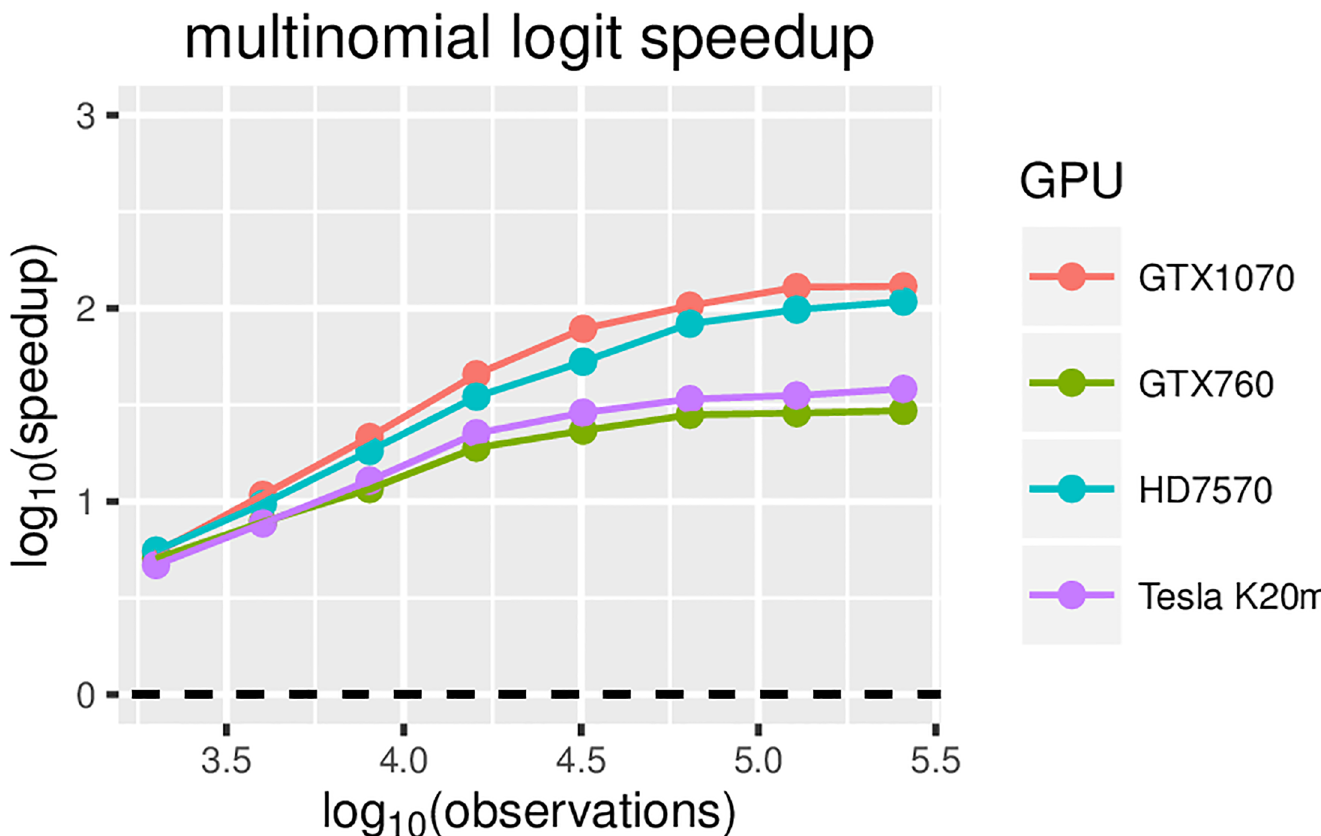
Fig 6. Multinomial logistic regression speedup relative to the CPU-only version (on an Intel i5-6600K @ 3.50 GHz) for different GPUs and an increasing number of observations.